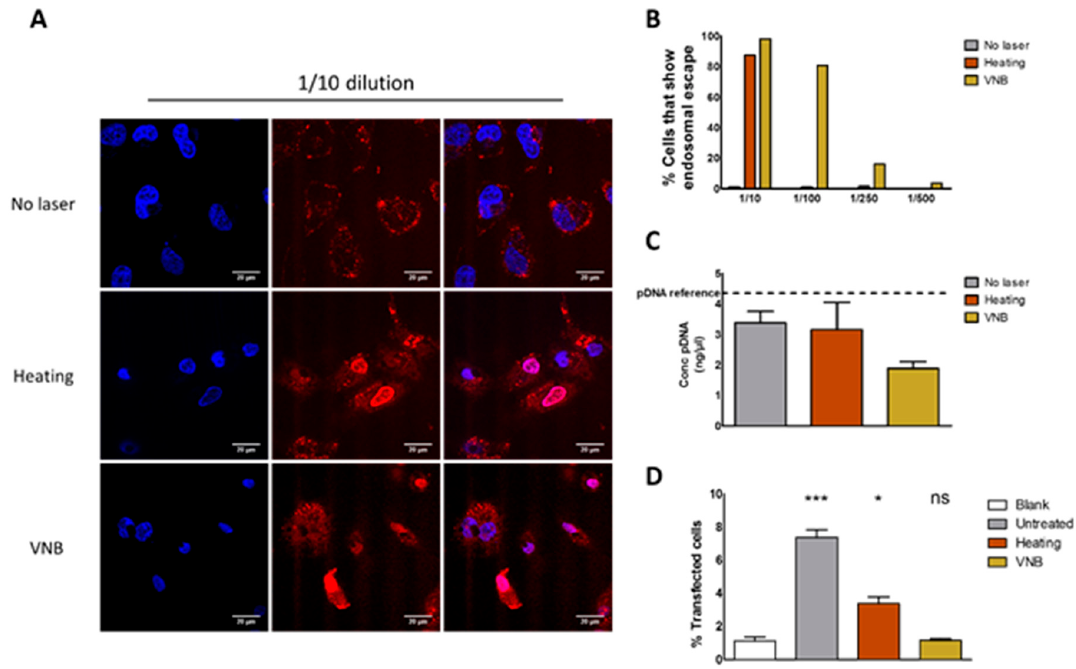
Figure 8. Evaluation of endosomal escape and pDNA integrity. ( A ) confocal images show the result of the endosomal escape assay without laser treatment, after heating and after VNB formation of JetPEI/pDNA/AuNP 5 pt complexes into which fluorescently labeled oligonucleotides (ONs) were co-complexed. Upon successful endosomal escape, the fluorescent ONs accumulate into the nucleus. The scalebar represents 20 µ m. The left column shows nuclei after Hoechst staining; the middle column shows AF647 ONs; and the right column shows the merge. ( B ) from confocal images, the percentage of cells is calculated that show endosomal escape (red nucleus) for the different dilutions of JetPEI/pDNA/AuNP 5 pt complexes. The data is obtained from the analysis of 60–100 cells per condition; ( C ) the pDNA concentration was measured via PicoGreen assay after the addition of dextran sulphate. The dotted line represents the amount of pDNA originally added to the complexes (pDNA reference). Graph shows mean ± SEM; n = 2; ( D ) graph shows the percentage of transfection efficiency after electroporation with isolated pDNA from JetPEI/pDNA/AuNP complexes. (*** p < 0.0001; * p < 0.05; ns = not significant).